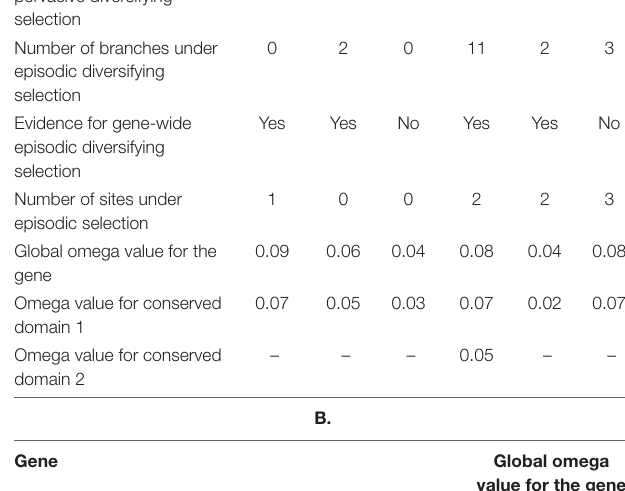
TABLE 1 | Molecular evolution of melanin pathway genes in Lepidoptera. branches and broad similarity with the species tree suggest that these genes have evolved with species divergence and do not seem to have undergone rapid evolution that would be incongruent with the species tree in any lineage. ( Figure 2 ). The molecular evolution of these genes was characterized by predominantly synonymous substitutions, suggesting constrained evolution (dN/dS values for most sites were well below 1, with mean dN/dS value for each gene ranging from 0.04 to 0.10). Rates for gene-wide synonymous substitutions were similar, but non-synonymous rates were